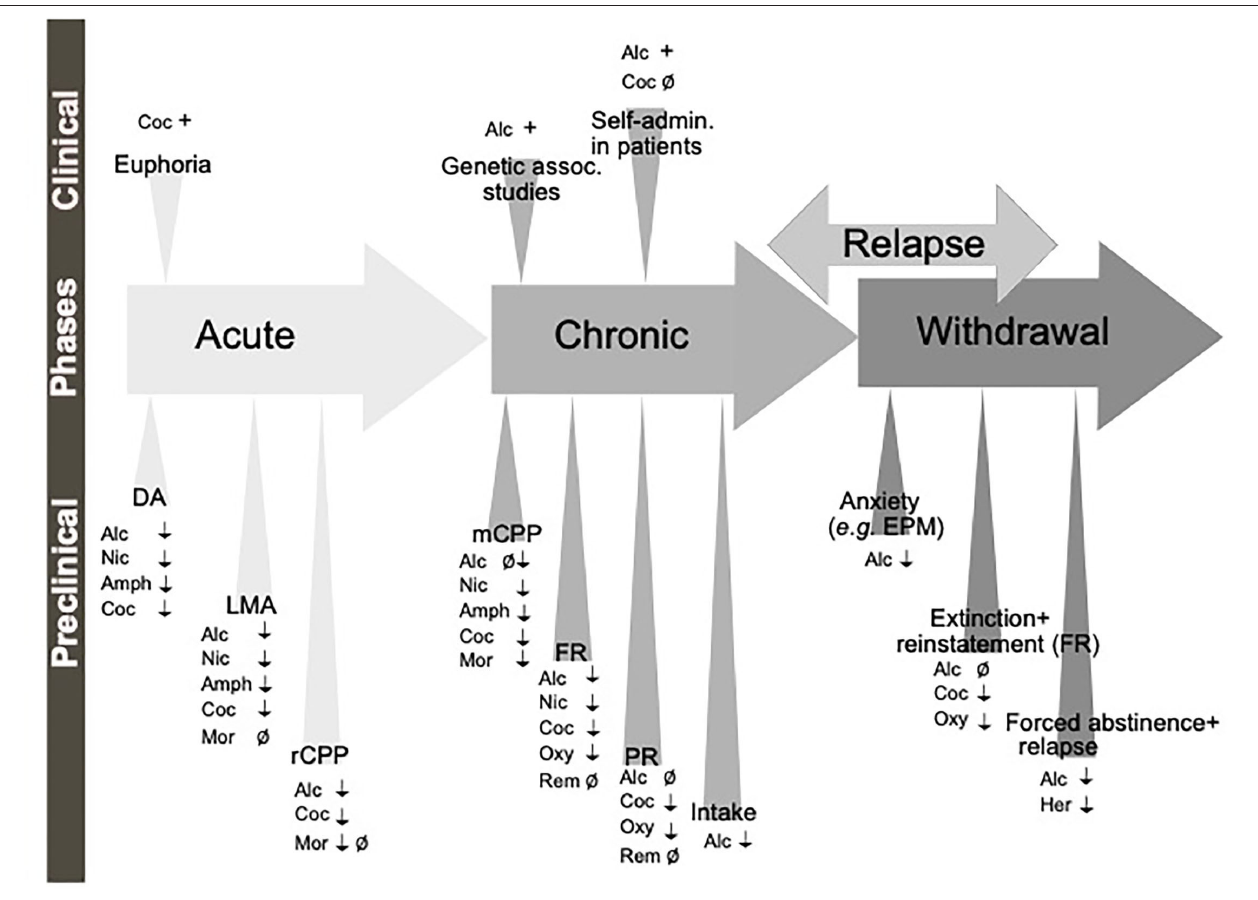
FIGURE 3 | Schematic illustration of the different phases of the addiction cycle which GLP-1 signaling influence. GLP-1 or GLP-1 receptor agonists influence behaviors of the addiction cycle, related to alcohol (Alc), nicotine (Nic), amphetamine (Amph), cocaine (Coc), morphine (Mor), remifentanil (Rem), Oxycodone (Oxy), heroin (Her). Positive association ( + ), negative association (–), increases/enhances ( ↑ ), decreases/attenuates ( ↓ ), conflicting evidence or no effect (Ø) on drug effect. Dopamine release in nucleus accumbens (DA), locomotor stimulation (LMA), reward of conditioned place preference (rCPP), memory of alcohol reward in the CPP test (mCPP), motivation (FR, and PR), Alcohol and drug intake (Intake), functional magnetic resonance